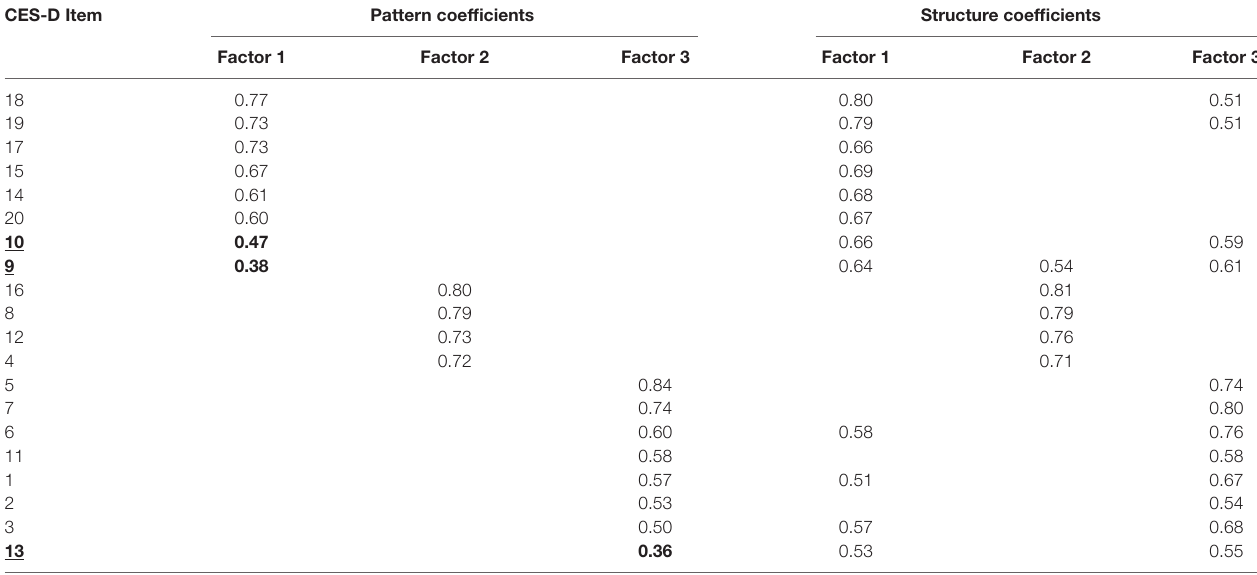
TABLE 1 | Pattern and Structure Matrices. CES-D Item